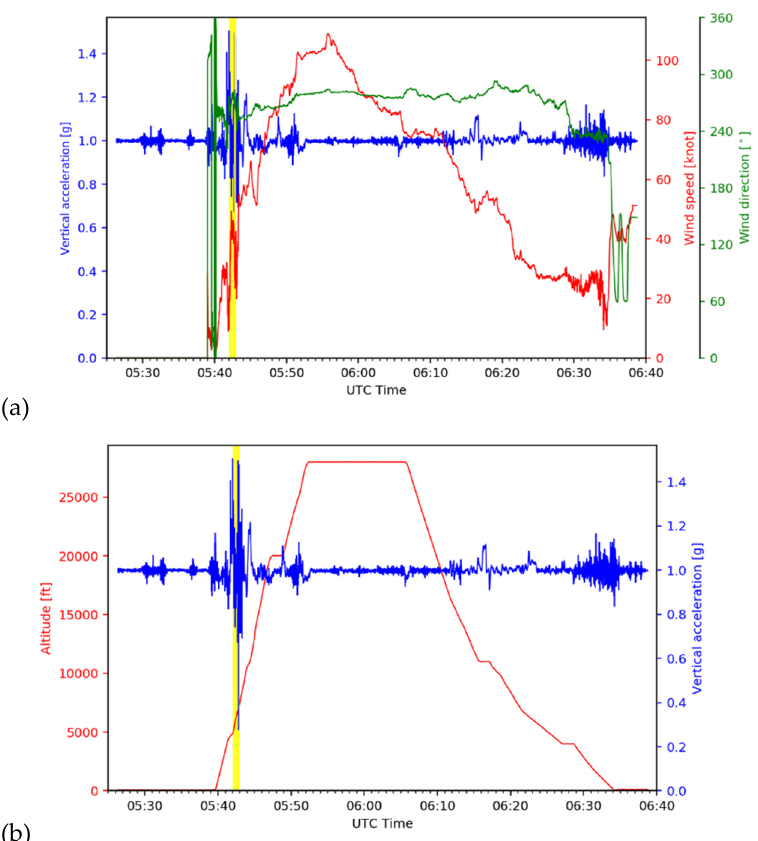
Figure 2. ( a ) Time series of the vertical acceleration (blue), wind speed (red), and wind direction (green) with the time of the turbu- lence incident (yellow) and ( b ) time series of the flight altitude (red) and vertical acceleration (blue) during 05:26–06:38 UTC on 28 October